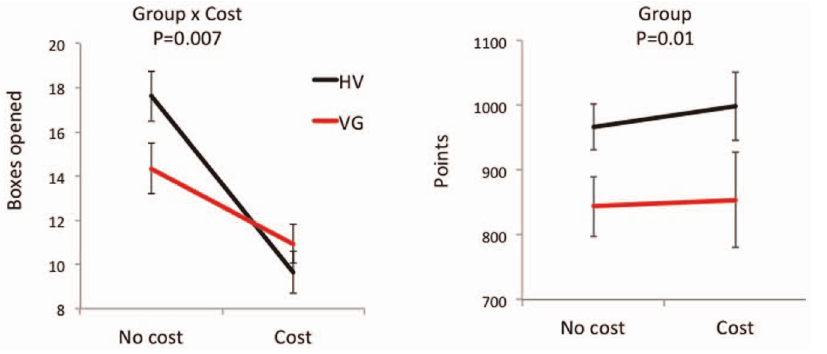
Figure 1. Information sampling task outcome measures. Mixed measures ANOVA of Information Sampling Task outcomes as a function of cost. Left: Boxes opened; Right: Points. Abbreviations: HV = healthy volunteers; VG = pathological gamers; YBOCS-G = modified Yale-Brown Obsessive Compulsive Score for gaming.